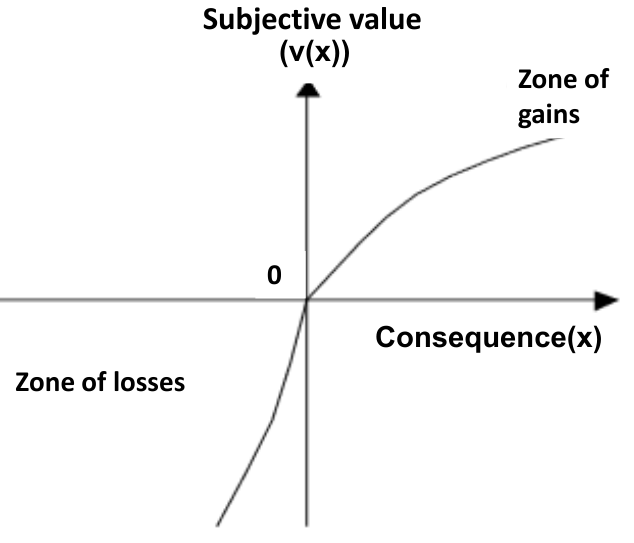
Figure 2. Valuation